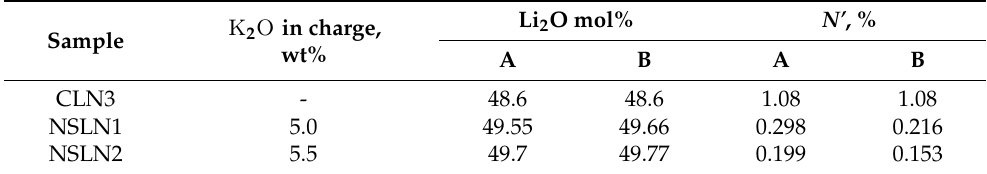
Table 2. Characteristics of LN crystal samples used in the